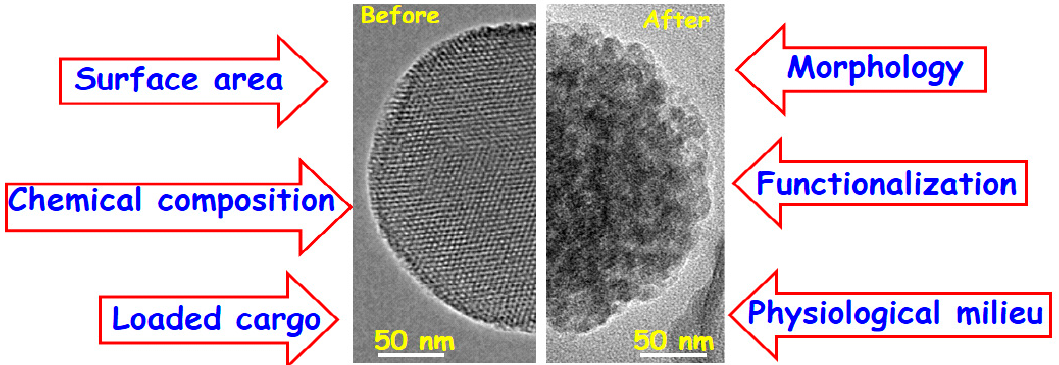
Figure 7. Main factors that drive the degradation of MSNs in physiological environment. TEM images of MSNs before and after being soaked in PBS under physiological conditions reveal the permanence of the structural and morphological characteristics after 8 days of in vitro test.